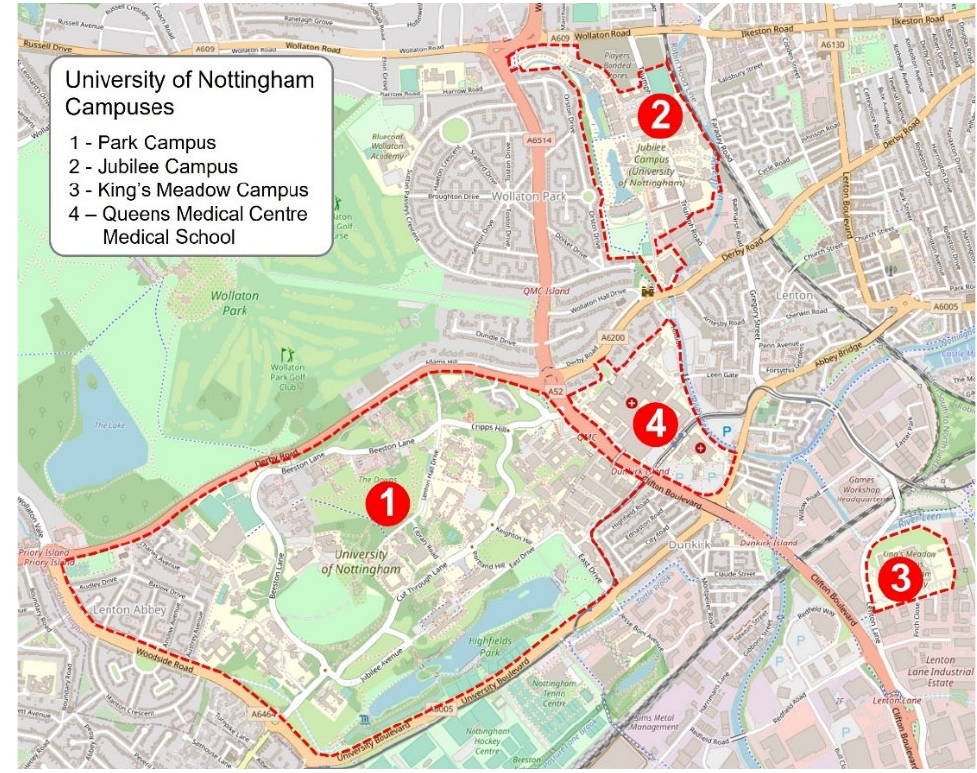
Figure 1. University of Nottingham campuses in Nottingham, UK.